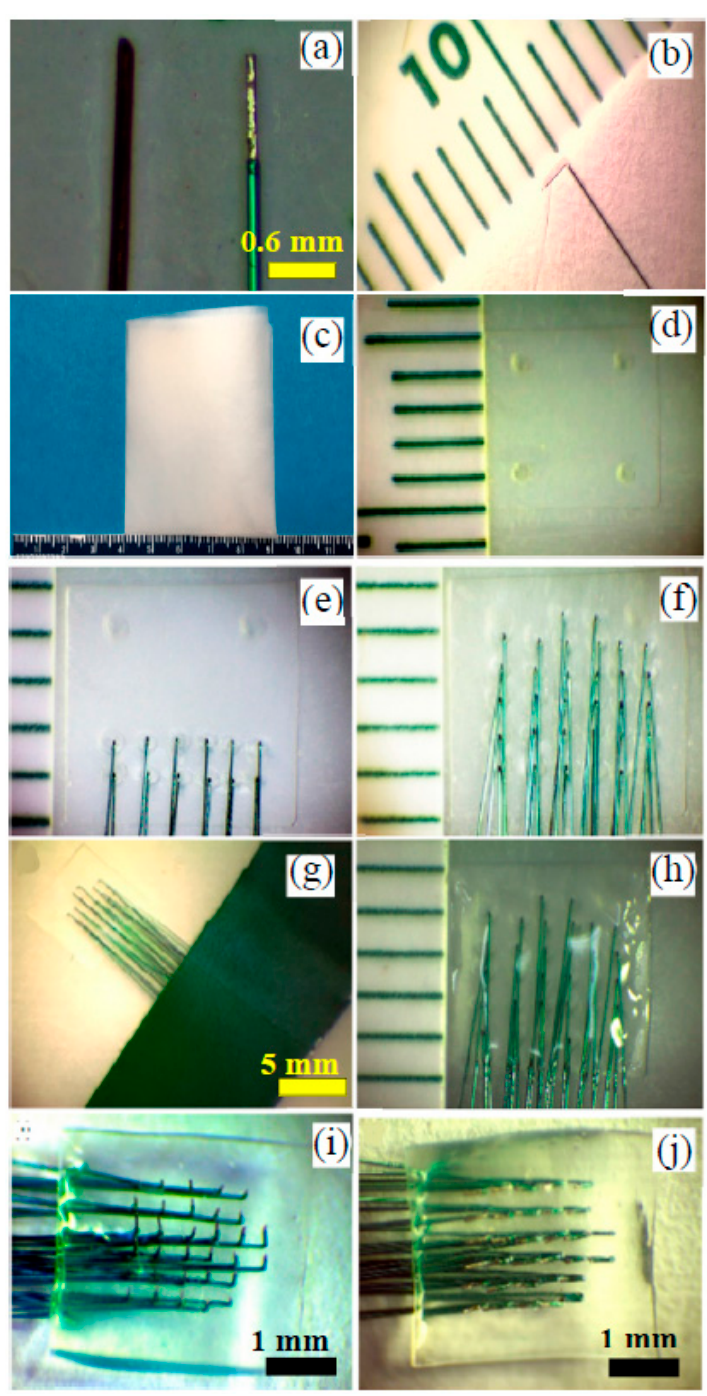
Figure 1. Fabrication process of the electrocorticography (ECoG) device. ( a ) Comparing the microwire with human hair; ( b ) Single wire specification with 90 degree bent; ( c ) 6 layer parafilm with an area of 50 × 50 mm 2 ; ( d ) 5 × 5 mm 2 area marked on the wax film and the thin PDMS film on the top; ( e ) Placement of 12 wires at 0.6 mm intervals in two rows of six on the wax film through the PDMS film; ( f ) Placement of all the 32 wires into rows with approximately equal spacing on the wax film through the PDMS film; ( g ) A tape covered the wire area to keep them down to the wax film; ( h ) Solidified PDMS on top of the stablohm microwires after removing from the oven; ( i ) View of the device after the wax film is removed; ( j ) After the wires were cut and bent all the way down and not touching with each other. All ruler intervals are 1 mm.